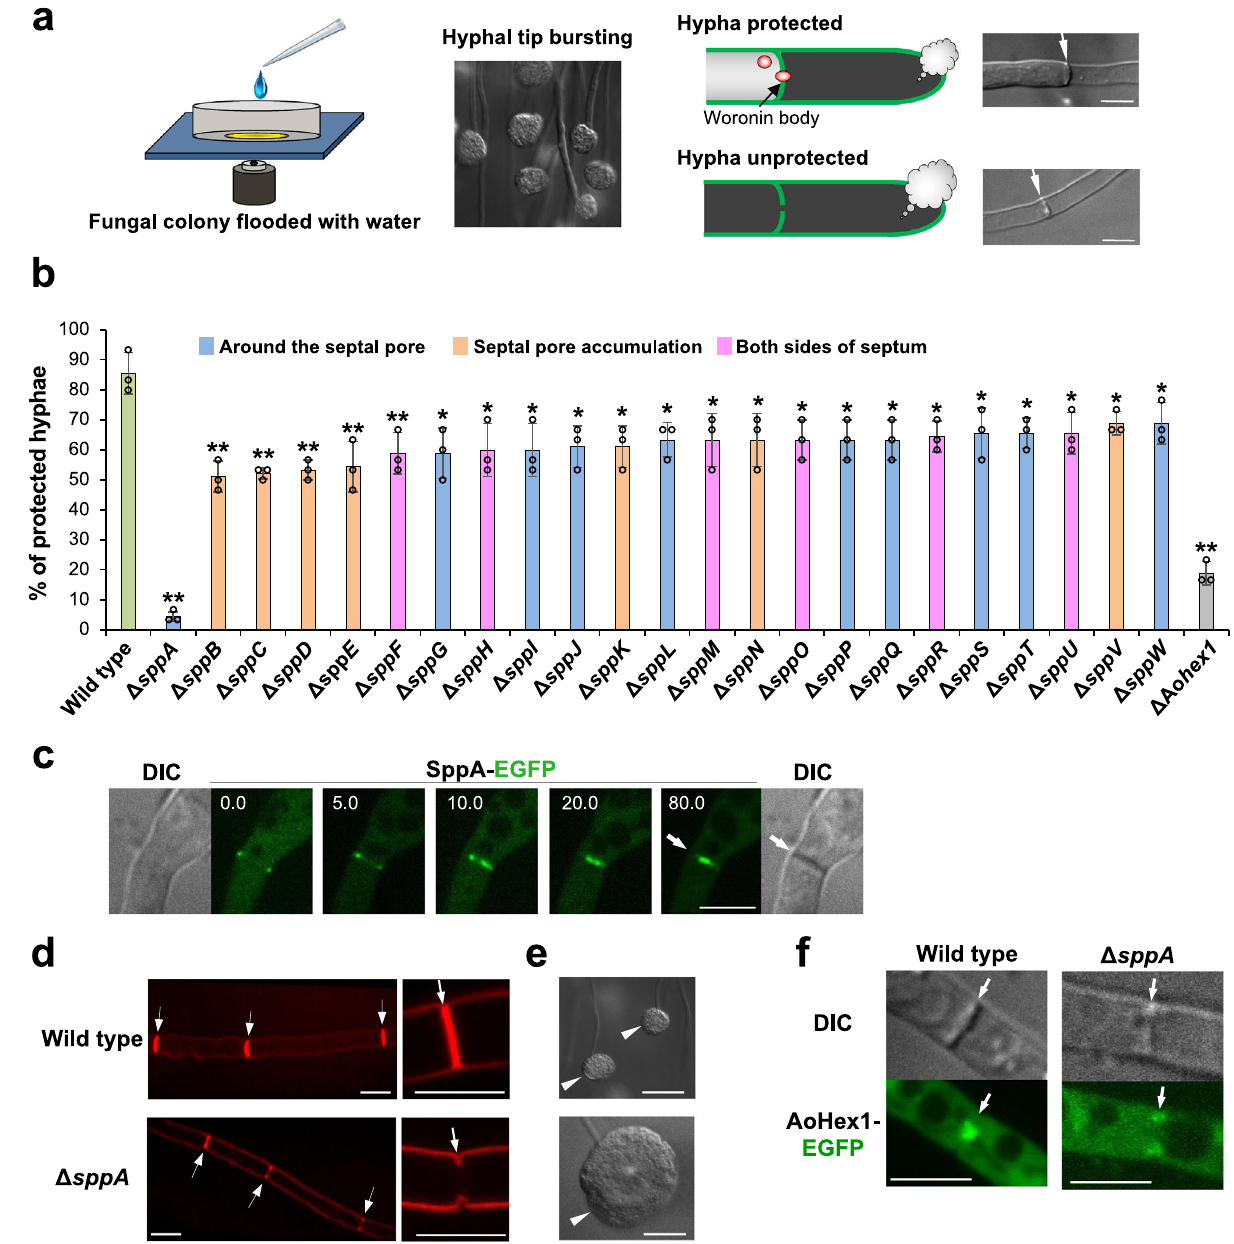
Fig. 4 | Regulation of septal pore plugging by SPP proteins upon wounding. a Schematic showing hyphal tip bursting induced by hypotonic shock. Cartoons and DIC images show wounded hyphae capable (top) or incapable (bottom) of protecting adjacent cells from cytoplasmic loss. Scale bars, 5 μ m. b Protection of fl anking cells from excessive loss of cytoplasm upon hyphal wounding. Thirty randomly selected hyphae showing hyphal tip bursting were observed in each experiment. Three independent experiments were performed,and the percentage of hyphae protected from the excessive loss of cytoplasm is shown on the Y axis. The data are presented as the mean of replicate experiments, and error bars represent standard deviations. Statistical signi fi cance was tested using two-tailed